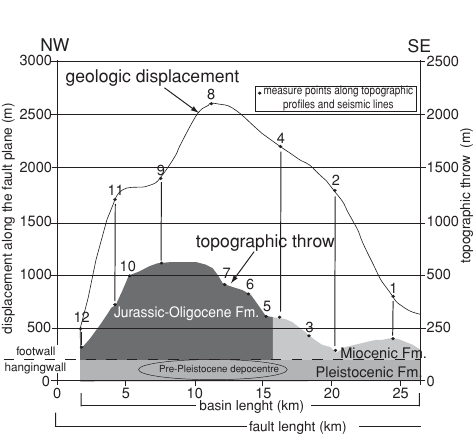
Fig. 4. Comparison between geologic displacement and topographic throw along the Gubbio Fault strike. Geologic throw has been calculated by using seismic lines on the base of the Marne a Fucoidi beds (115-95 My) offset (from Mirabella, 2003). Topographic throw is measured as difference between highest elevation and surface of the basin. The position of the pre- Pleistocene depocentre, as reconstructed by Meni- chetti (1992), the basin length and the lithologies cropping out in the fault footwall are reported